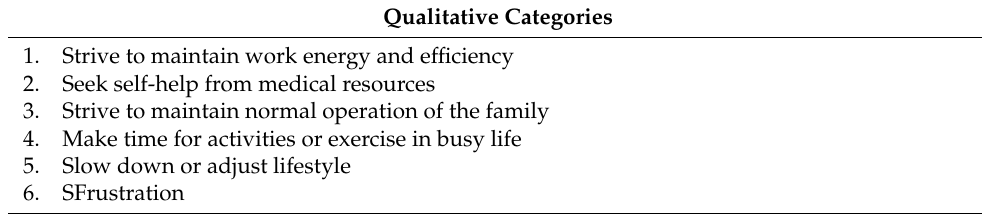
Table 1. Qualitative categories based on grounded theory.